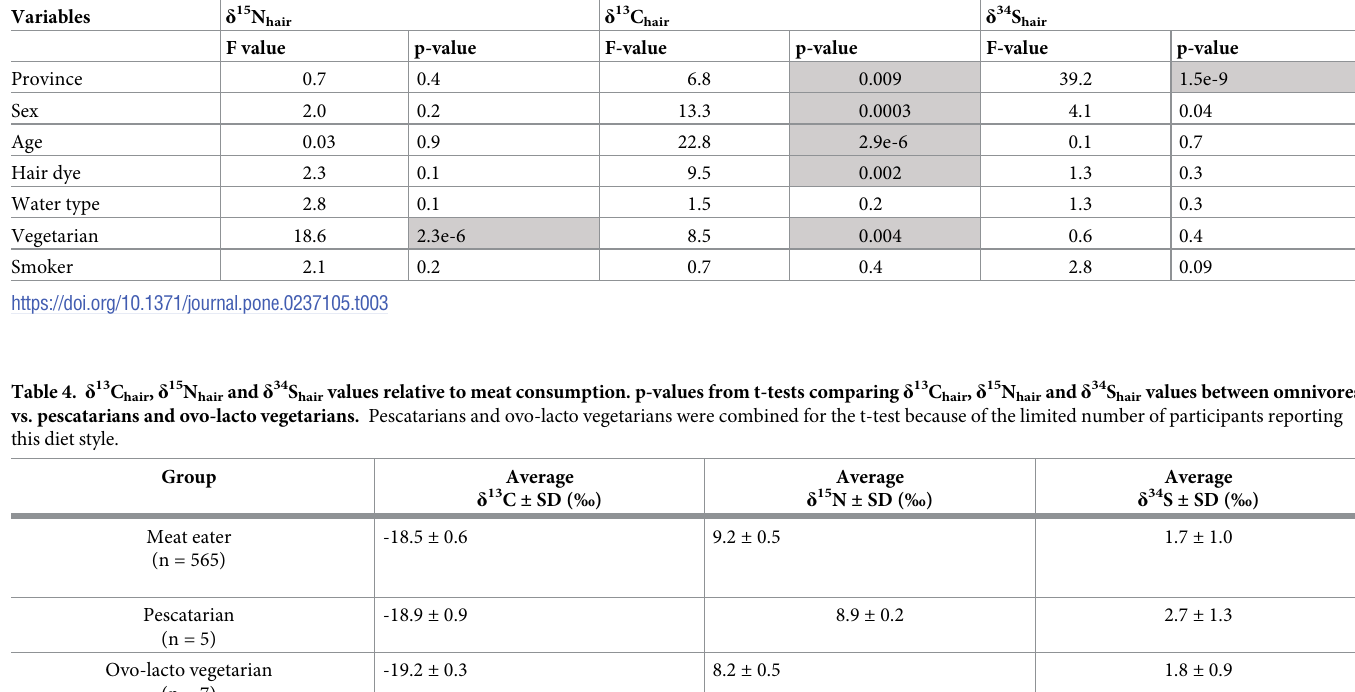
Table 3. Anova between isotopic data in hair and the categorical predictors. Grey indicates significant differences in the mean isotopic values between groups of that variable (p-value < 0.01). For those significant variables relation between groups and isotopic values are further tested through a t-test. Variables